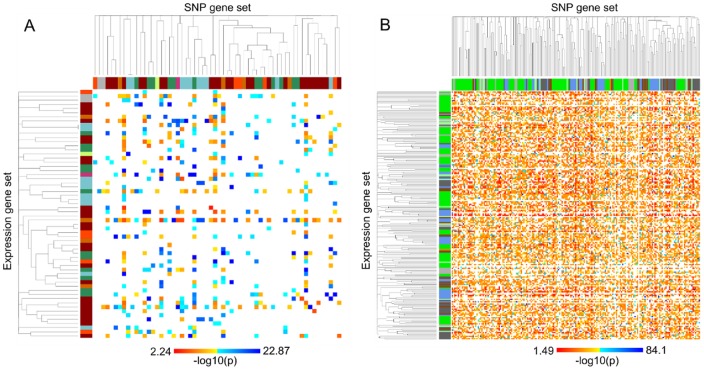
Heatmaps with points indicating associations (FDR <5%) between SNP (x-axis) and expression (y-axis) GSs.SNP and expression GSs are indexed based on hierarchical clustering using distances between GSs (distance determined by average proportion of genes shared between GSs). The color of the points indicate the level of association significance (blue  =  less significant, red  =  more significant)